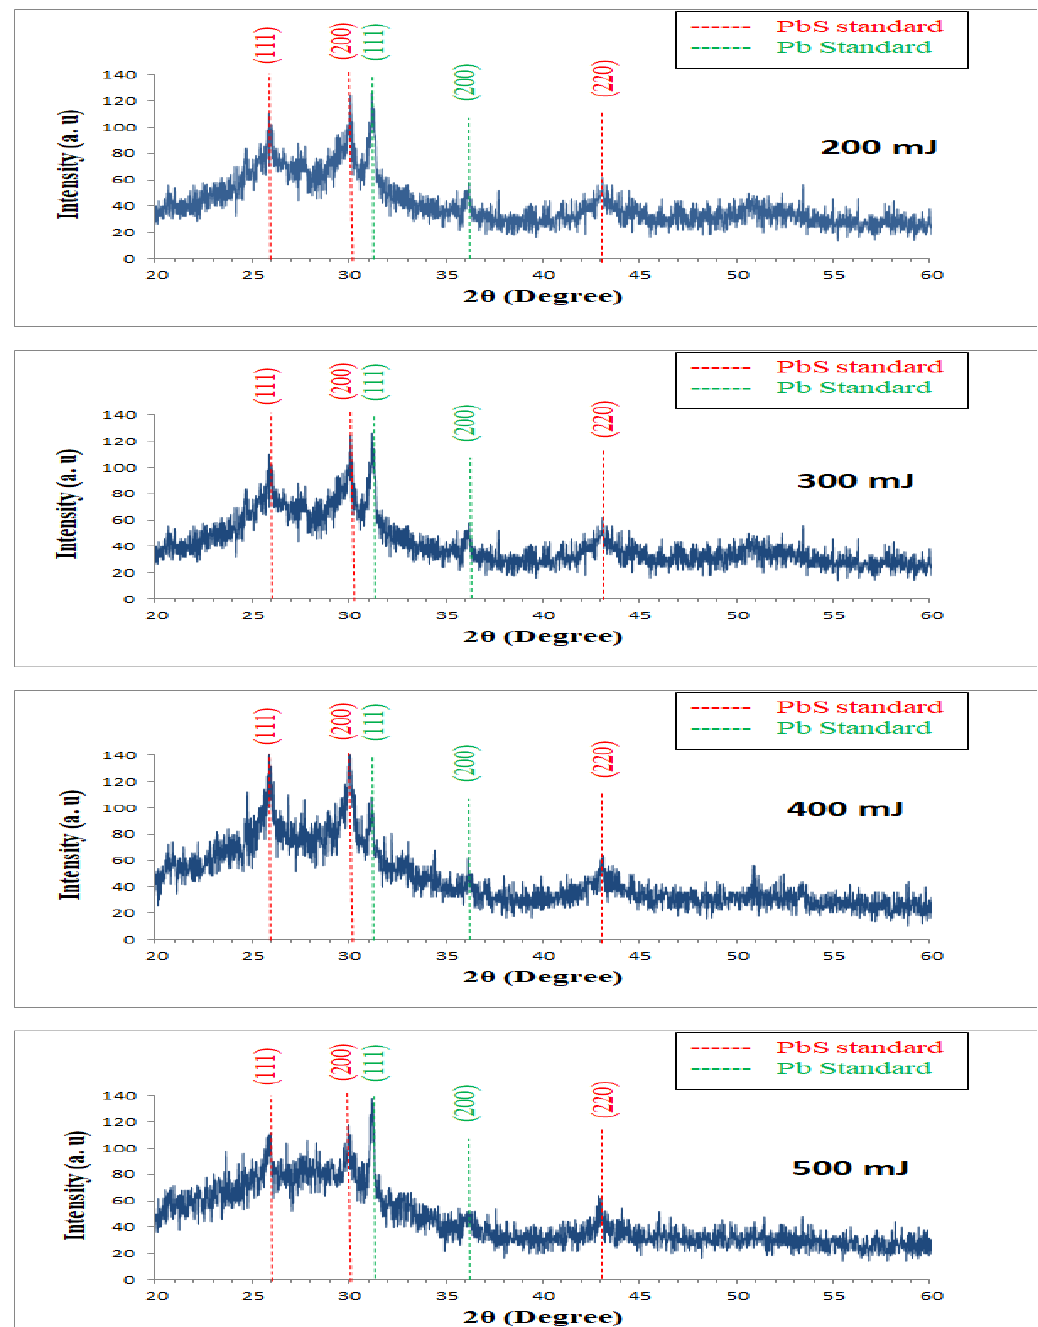
Fig.1: The X-RD spectra of PLD-prepared lead sulfide nanostructure with different laser